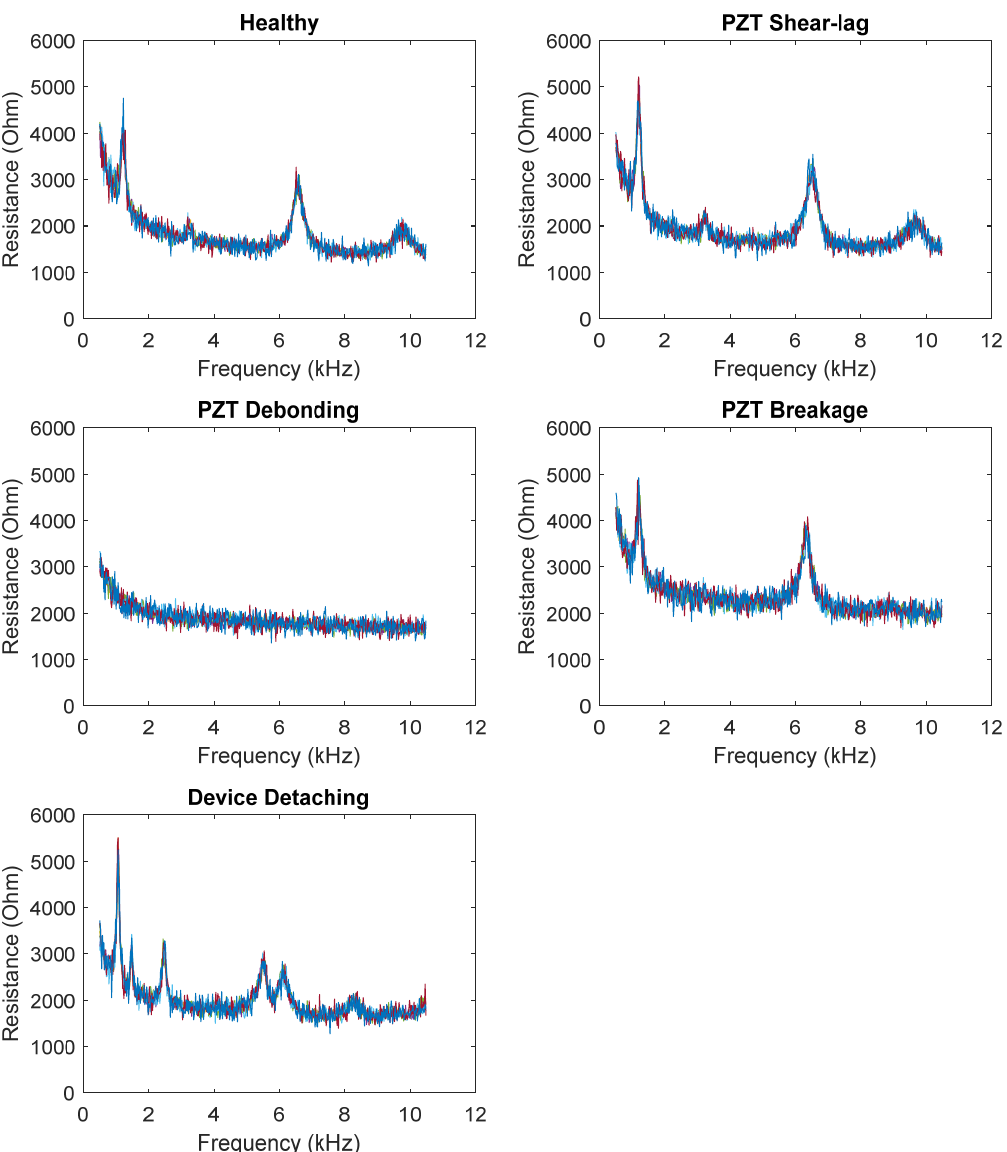
Figure 15. Sample noise ‐ contaminated resistance signals of the testing dataset (TestD1).